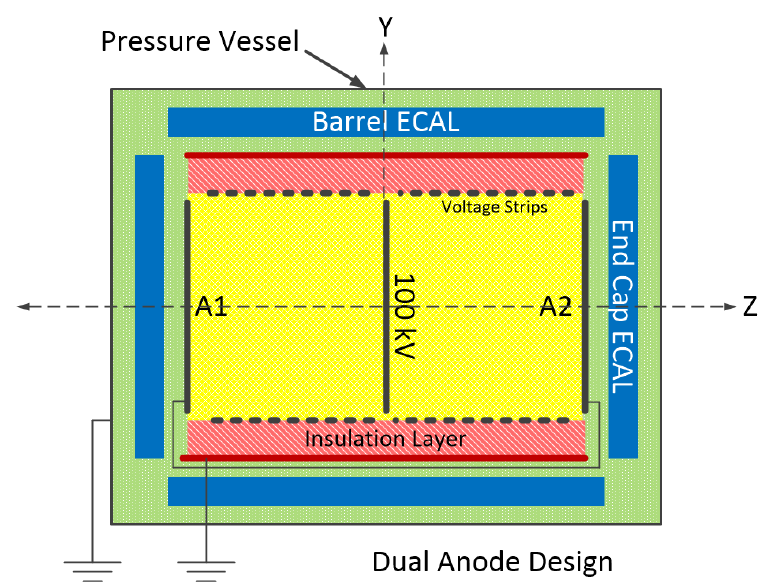
Figure 4. Placement of voltages in the dual-anode